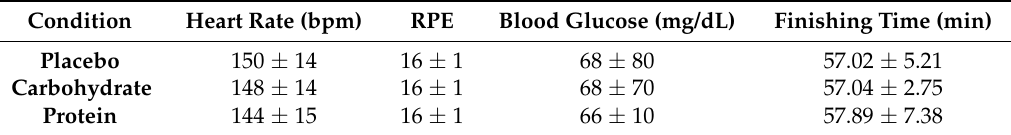
Table 1. The 30 km time trial prior to mouth rinse intervention.